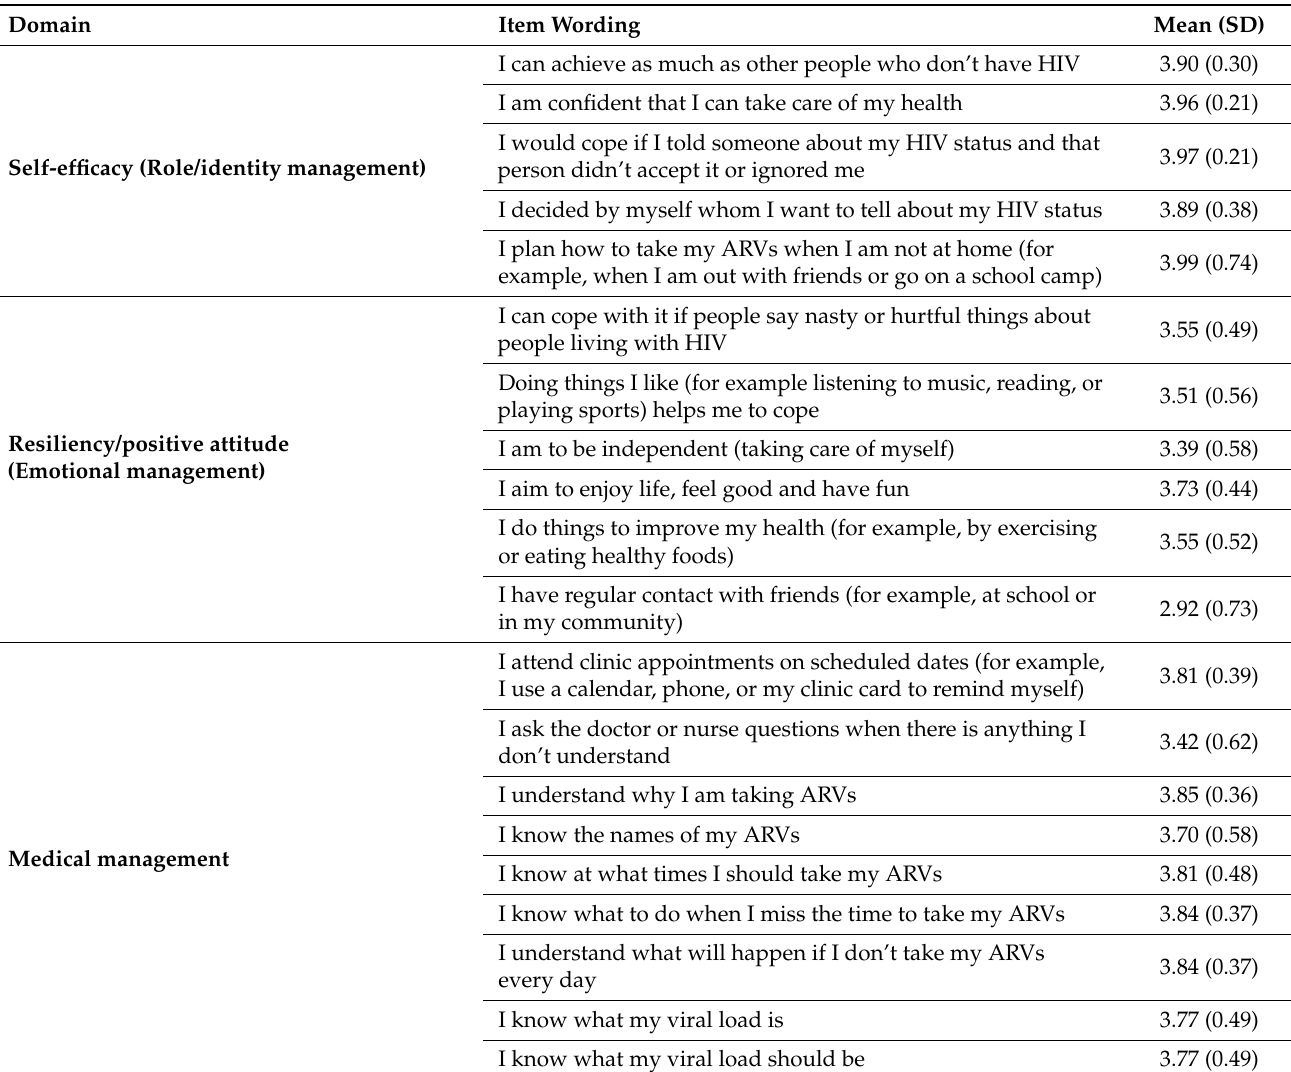
Table 4. HIV self-management (adapted 20-item